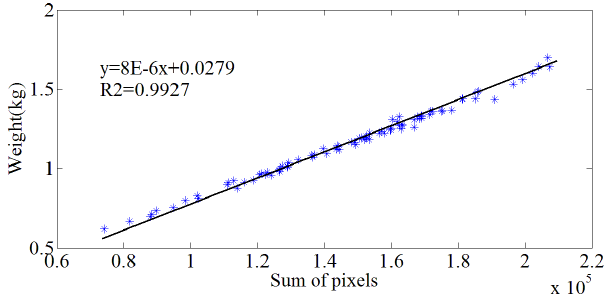
Fig. 7. The result of calibration model on